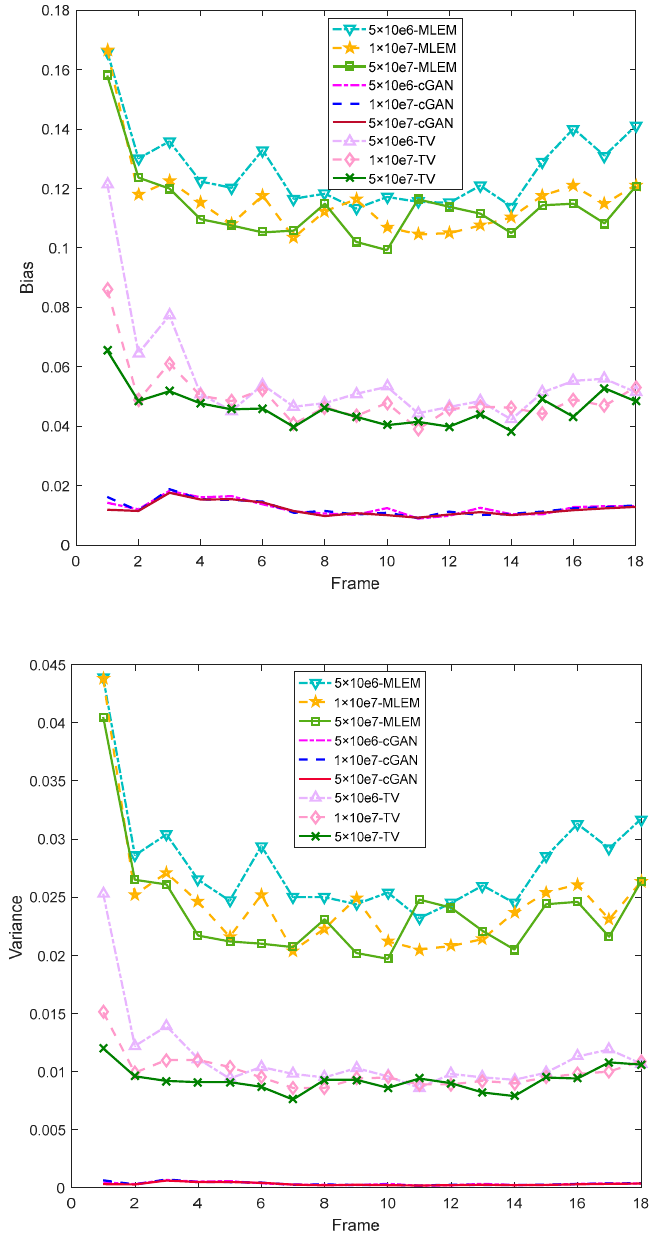
Figure 10. Bias and variance of three methods (MLEM, TV, and cGANs) of Zubal thorax phantom with different counts. The top three curves represent the results of the MLEM method, the middle curves represent results of the TV method, and the bottom curves correspond to the proposed method. With increasing counts, the bias and variance values of the MLEM and TV methods decrease, but there is a slight effect on the cGANs